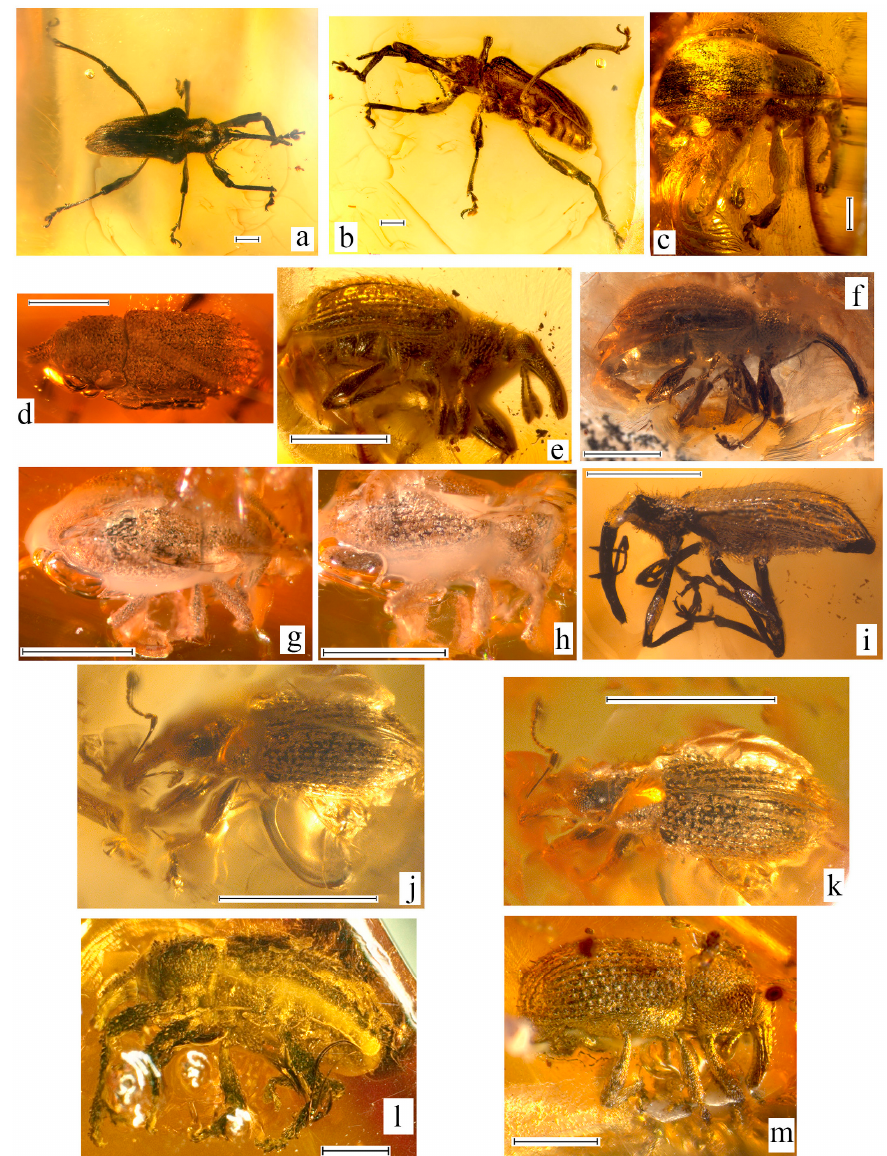
Figure 8. Habitus of Curculioninae from Baltic amber. ( a , b ) Baltocurculio manukyani gen. et sp. nov. , holotype, KRAM , no. BX 100-19: body, dorsally ( a ); body, ventrally ( b ). ( c ) Pseudoergania perkovskyi , holotype, ISEA , no. BA2017/7, body, laterally. ( d ) Succinostyphlus mroczkowskii , holotype, EIW , no. 6427, body, dorsally. ( e ) Archaeoeugnomus balticus , holotype, ISEA , no. BA2012/15, body, laterally. ( f ) Anthonoeugnomus barsevskisi gen. et sp. nov. , holotype, ISEA , no. BA2017/2, body, laterally. ( g , h ) Pachytychius eocenicus , holotype, ISEA , no. BA2011/7: body, dorso-laterally ( g ); body, laterally ( h ). ( i ) Mazurieugnomus pilosus gen. et sp. nov. , holotype, ISEA , no. 2016/1, body, laterally. ( j , k ) Groehnius parvum sp. nov. , holotype, FEH , no. 649: body, dorso-laterally ( j ); body, dorsally ( k ). ( l ) Succinostyphlus mroczkowskii , specimen, ISEA , no. 2012/20, body laterally. ( m ) S. mroczkowskii , GPIH , no. SEBS00292a, body, laterally. Scale bars: 1.0 mm. See Section 2 for names of collections.